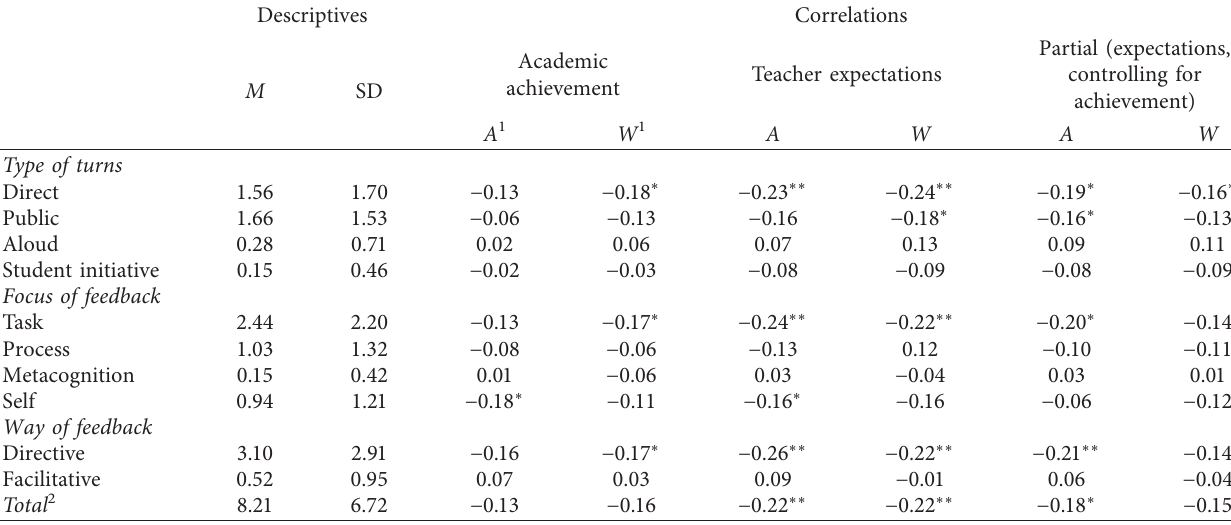
Table 3: Descriptive statistics for teacher-student interactions during whole class teaching and bivariate and partial correlations with academic achievement and teacher expectations, across ( A ) and within ( W ) classrooms ( N �